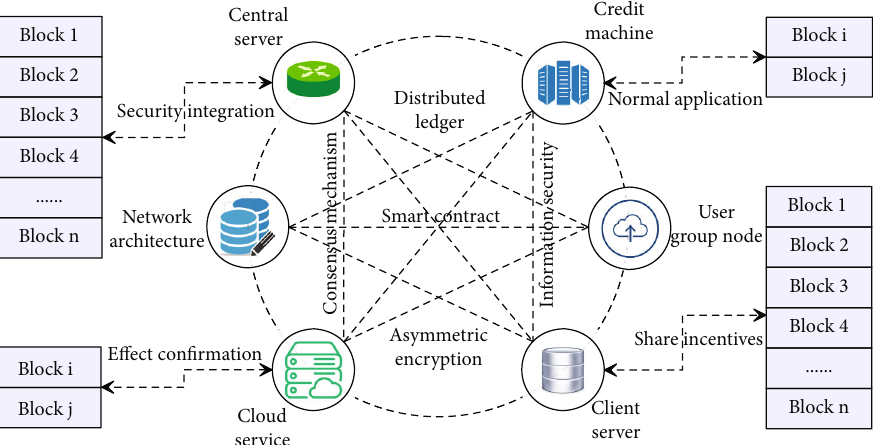
Figure 1: Data quality collaboration model for public administration and resource allocation based on blockchain and structured occupational therapy.